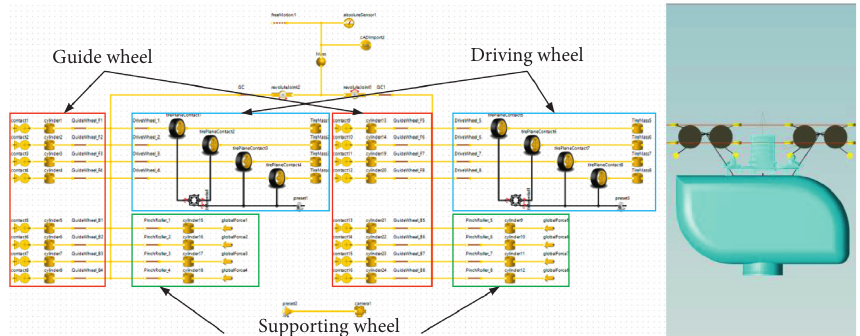
Figure 24: Model of the double-bogie